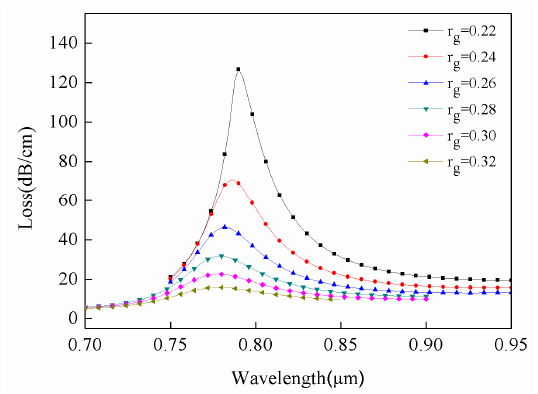
Figure 6. Loss spectra of the different radius of gold wire. Conditions: r a = 0.6 μ m, r b = 0.2 μ m, and